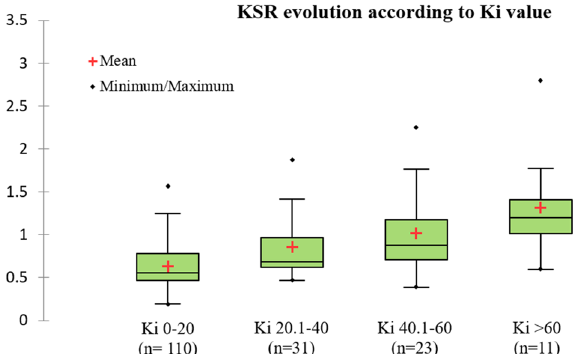
Figure 3. KSR evolution according to Ki intervalls (0–20, 20.1–40, 40.1–60, and > 60 ml/min/100 ml). KSR was defined as the ratio between Ki-tumor to SUVmean-tumor (KSR).